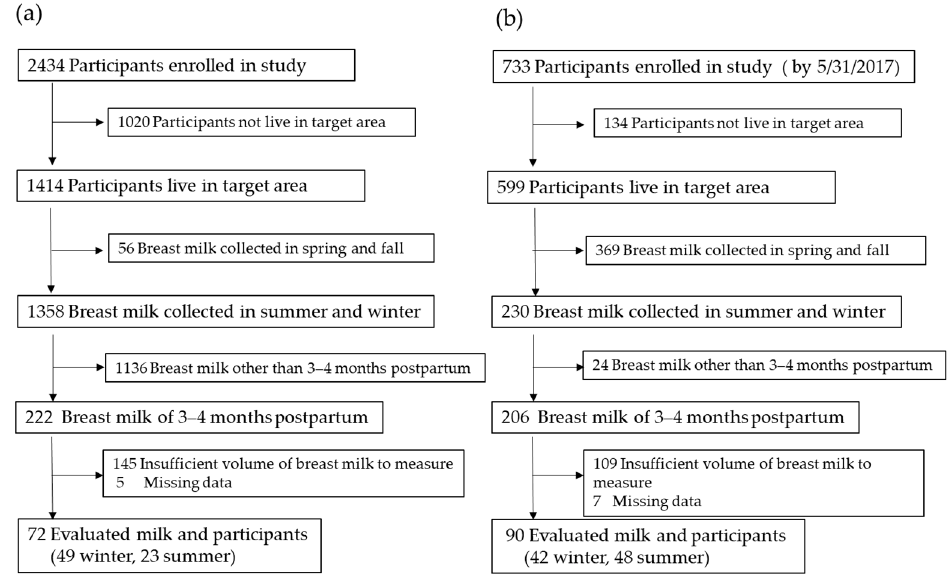
Figure 1. Participant and breast milk sample flow chart of the studies in 1989 ( a ) and 2016–2017 ( b ).